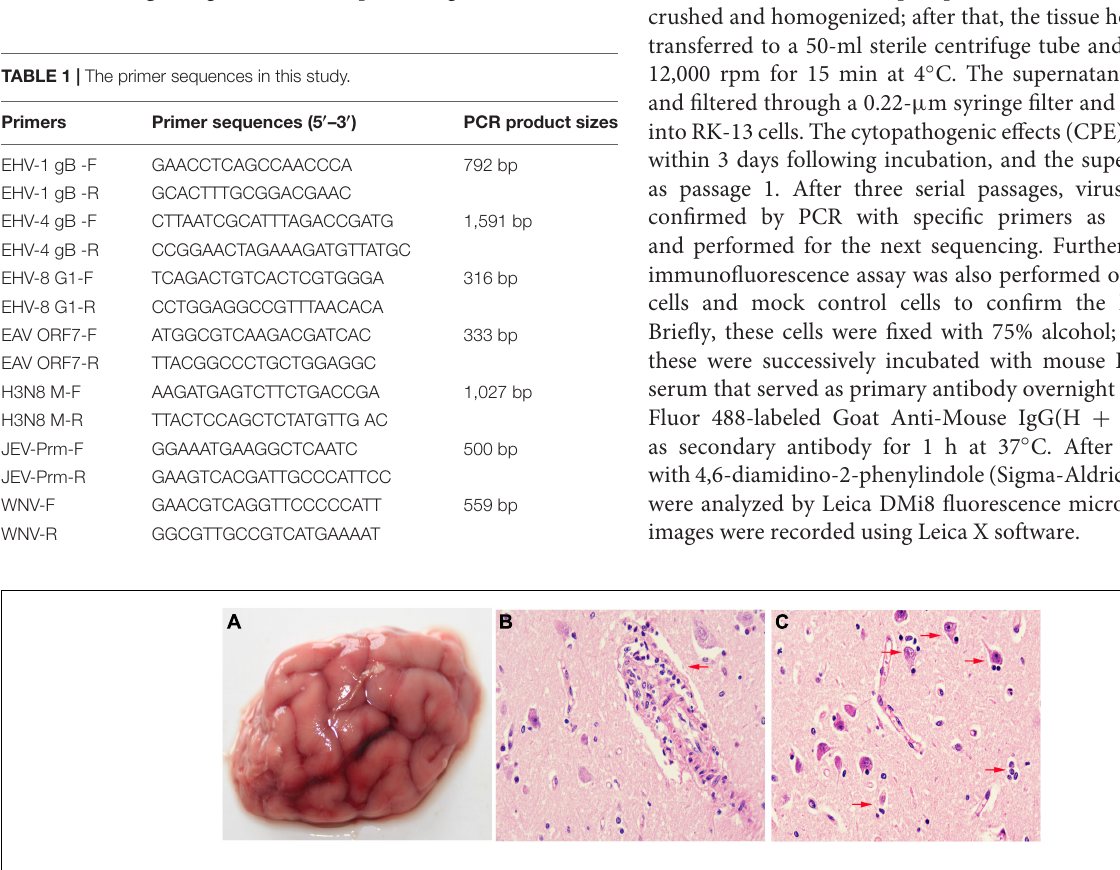
FIGURE 1 | Gross lesions of a dead donkey with a severe neurological disease. (A) Moderate meningeal edema lesions in the brain; severe viral encephalitis including perivascular cuffing (B) , neuronophagia, and satellitosis (C) . HE, × 400.